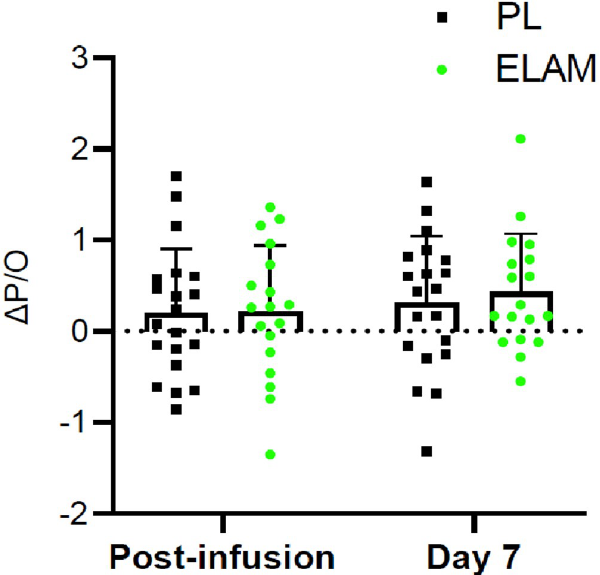
Table in S1 File. This stability of resting P/O indicates that the improvement in ATP the result of higher flux through the ETC rather than more efficient synthesis of ATP per O uptake.